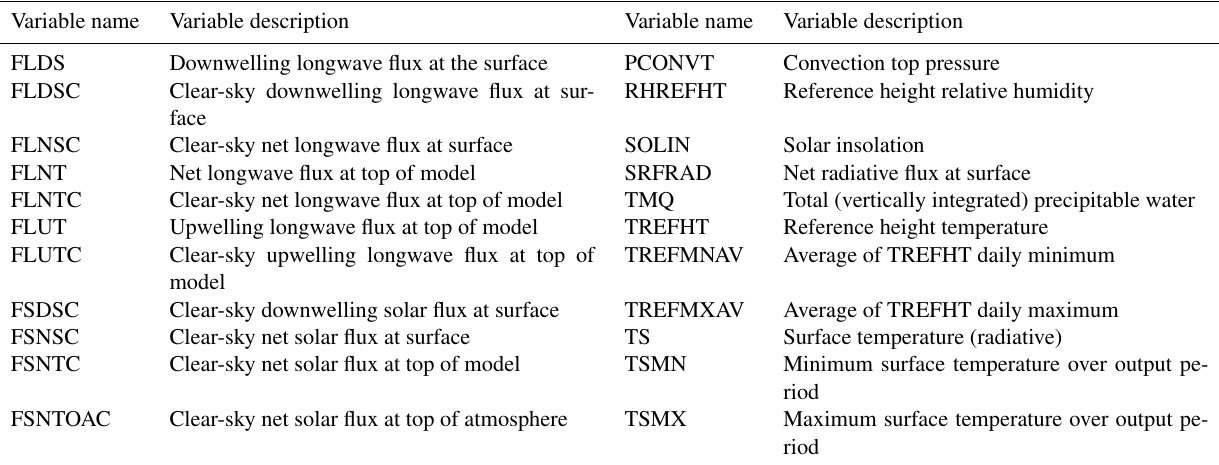
Table 1. Descriptions of the 22 climate model data